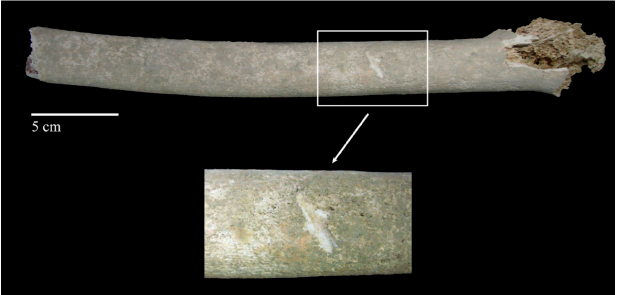
Figure 4. Human skeletal remains from the late medieval cemetery of Corfinio (12th–13th century CE, Italy). Anterior view of the diaphysis of the left femur from an adult individual showing a large linear mark that could be confused with a mark caused by a canine tooth dragging across compact bone; however, this large mark was caused by a sharp tool during a deficient excavation process (i.e., lesion of post-mortem origin). Image courtesy of C. Tanga from her bachelor’s thesis